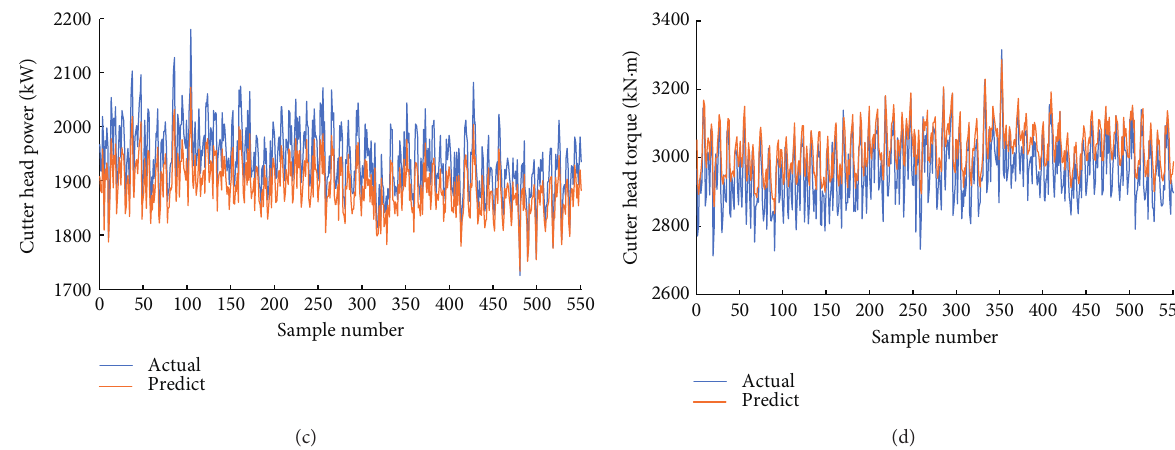
Figure 12: Prediction results of GRU model. (a) Prediction results of total thrust F . (b) Prediction results of penetration e . (c) Prediction results of cutterhead power P . (d) Prediction results of cutterhead torque T .